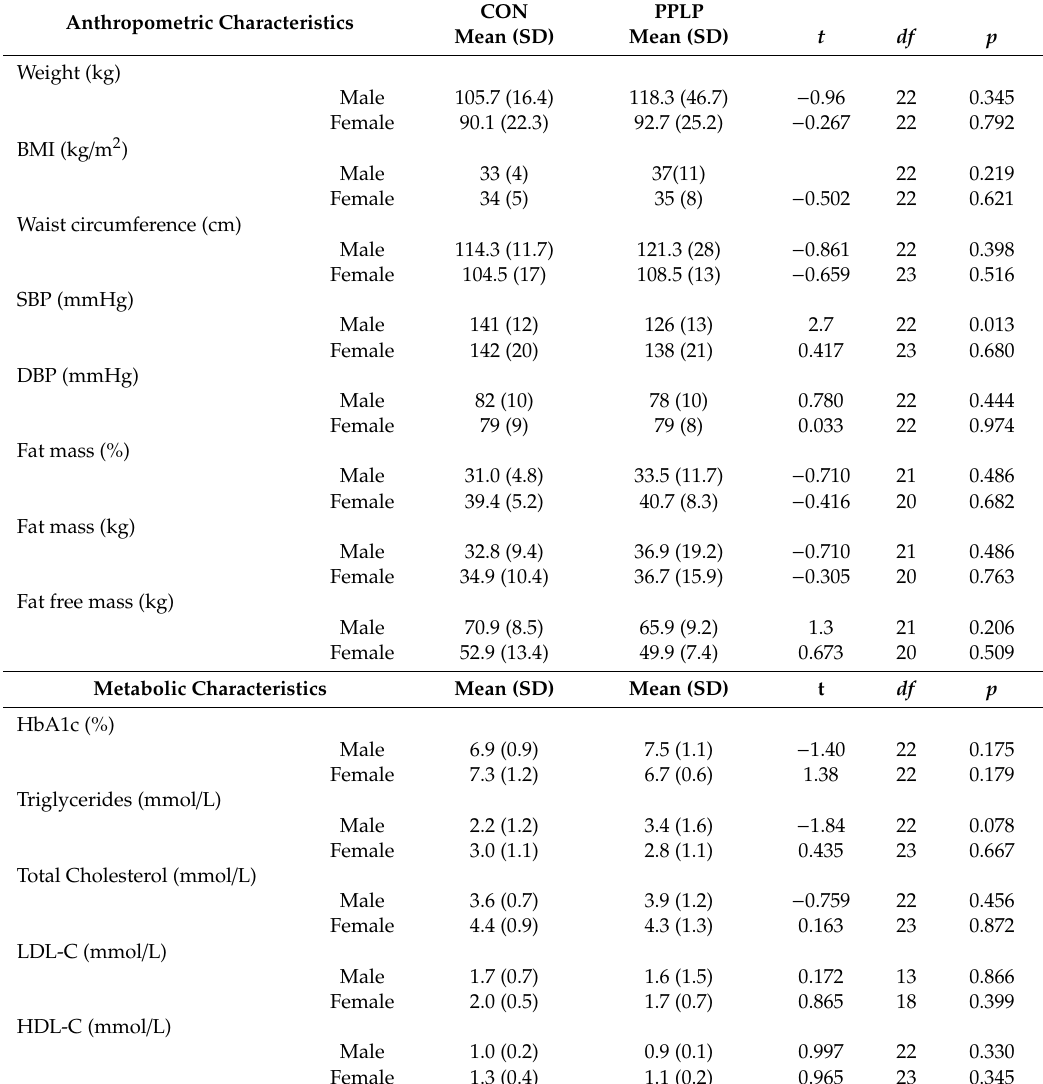
Table 2. Baseline metabolic